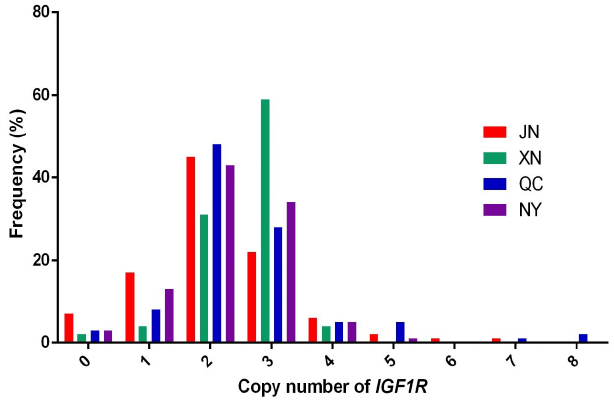
Figure 1. Copy number distributions of IGF1R in four Chinese cattle breeds. Histograms show the frequency of individuals with a different copy number of the IGF1R gene. Copy numbers were rounded to the nearest integer.